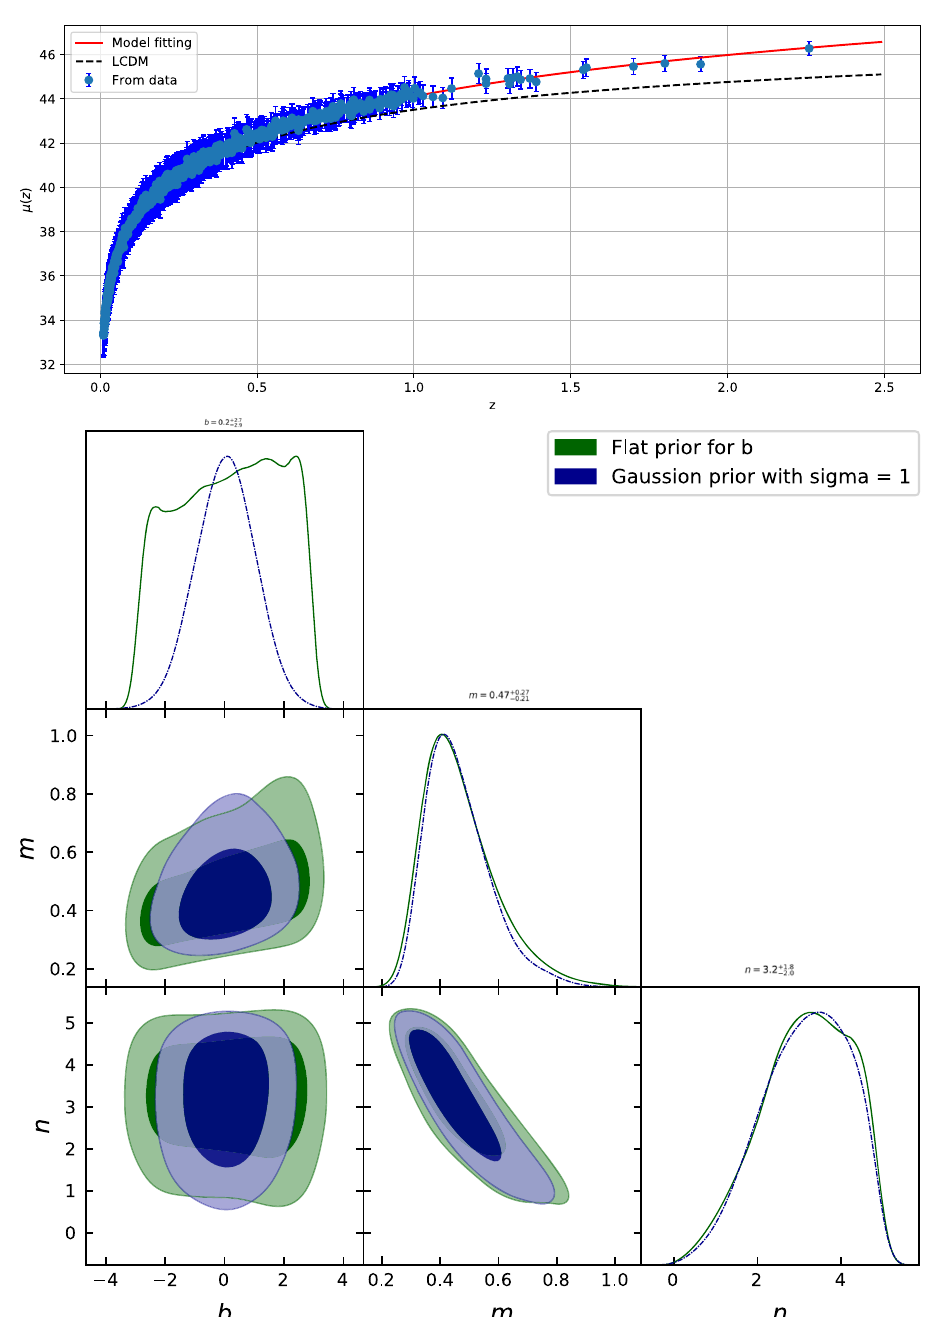
Fig. 1 The plot of distance modulus μ( z ) vs. redshift z for our model shown in red line and (cid:2) CDM in black dotted line which shows nice fit to the 1048 points of the Pantheon datasets shown with it’s error bars